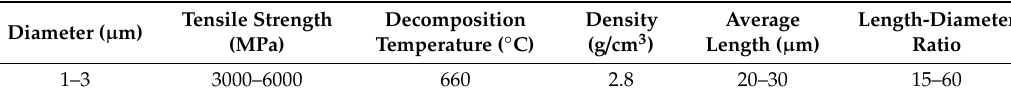
Table 3. Characteristics of CaCO 3 whiskers.